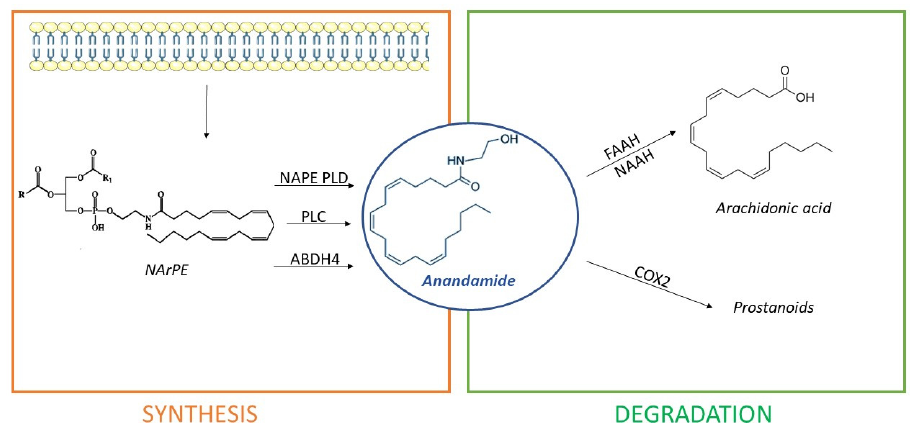
Figure 4. Anandamide (AEA) is synthesized from cell membrane lipid precursors through hydrolysis of N-arachidonoyl-phosphatidyl ethanolamine (NArPE) by N-acyl phosphatidylethanolamine phospholipase D (NAPE-PLD), α / β -hydrolase domain type-4 (ABHD4), or phospholipase C (PLC) action. It is then degraded in arachidonic acid by enzymes fatty acid amide hydrolase (FAAH) or N-acylethanolamine-hydrolyzing acid amidase (NAAA) or in prostanoids by cyclooxygenase-2 (COX2).